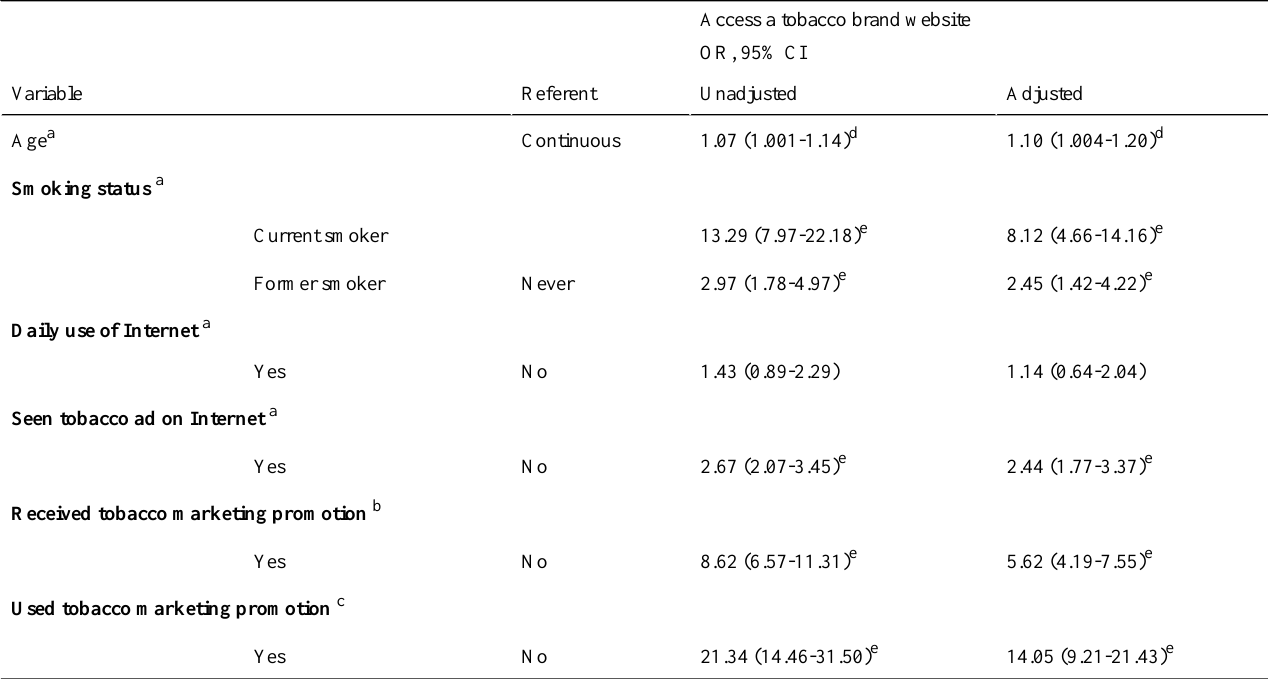
Table 3. Predictors of medical students and physicians accessing tobacco brand websites, Buenos Aires, Argentina,